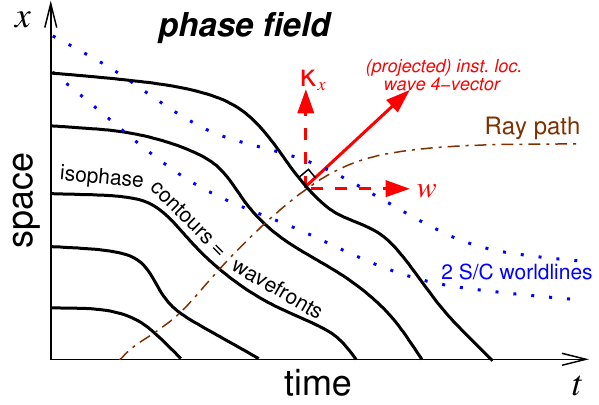
Fig. 1. Illustration of a 2-dimensional projection (time and one spa- tial component) of the instantaneous local wave 4-vector under the assumptions of geometrical optics and isotropy. From the phase field of a physical quantity one can define wavefronts in this illustra- tion as isophase contour lines (solid curves) and a ray path (dashed curve) that are everywhere orthogonal to the wavefronts. The in- stantaneous local wave vector κ is the spatial gradient of the phase field and, in the geometrical optics approximation, κ is tangent to the ray path. The problem addressed in this paper is how to estimate κ from real valued discrete measurements taken along world lines (dotted